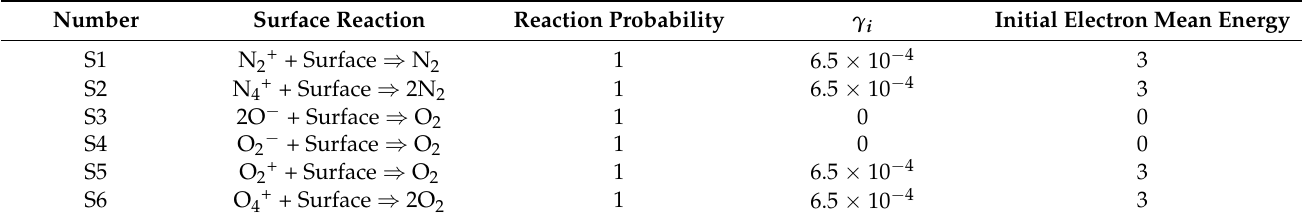
Table A2. Surface reactions considered in the